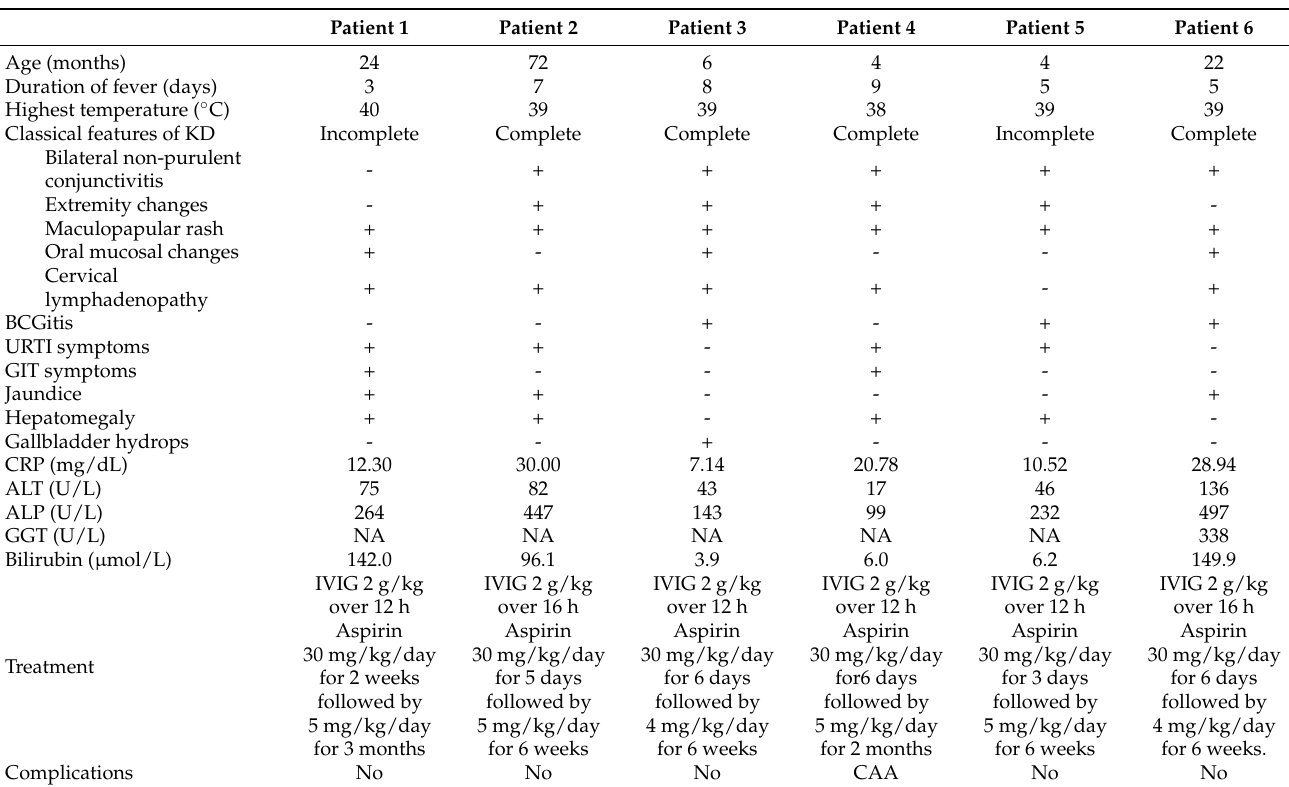
Table 1. Summary of the Clinical Hepatobiliary Presentation and Management of the KD